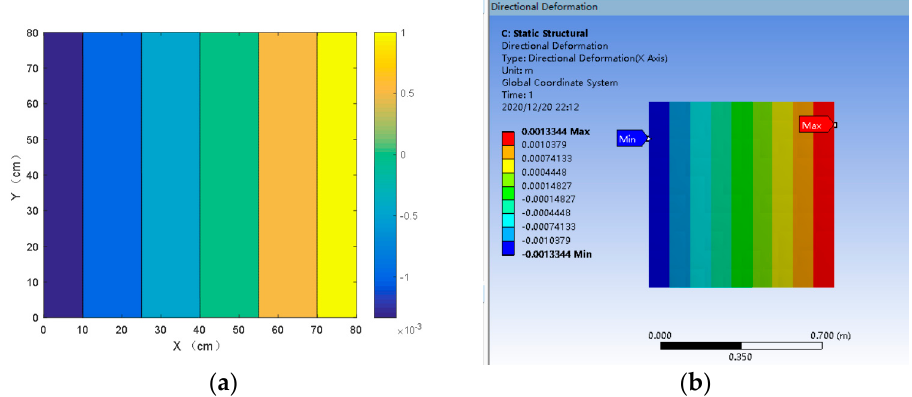
Figure 11. Thermoelasticity calculation results of x direction displacement (( a ) FEMN solution and ( b ) analytical solution).